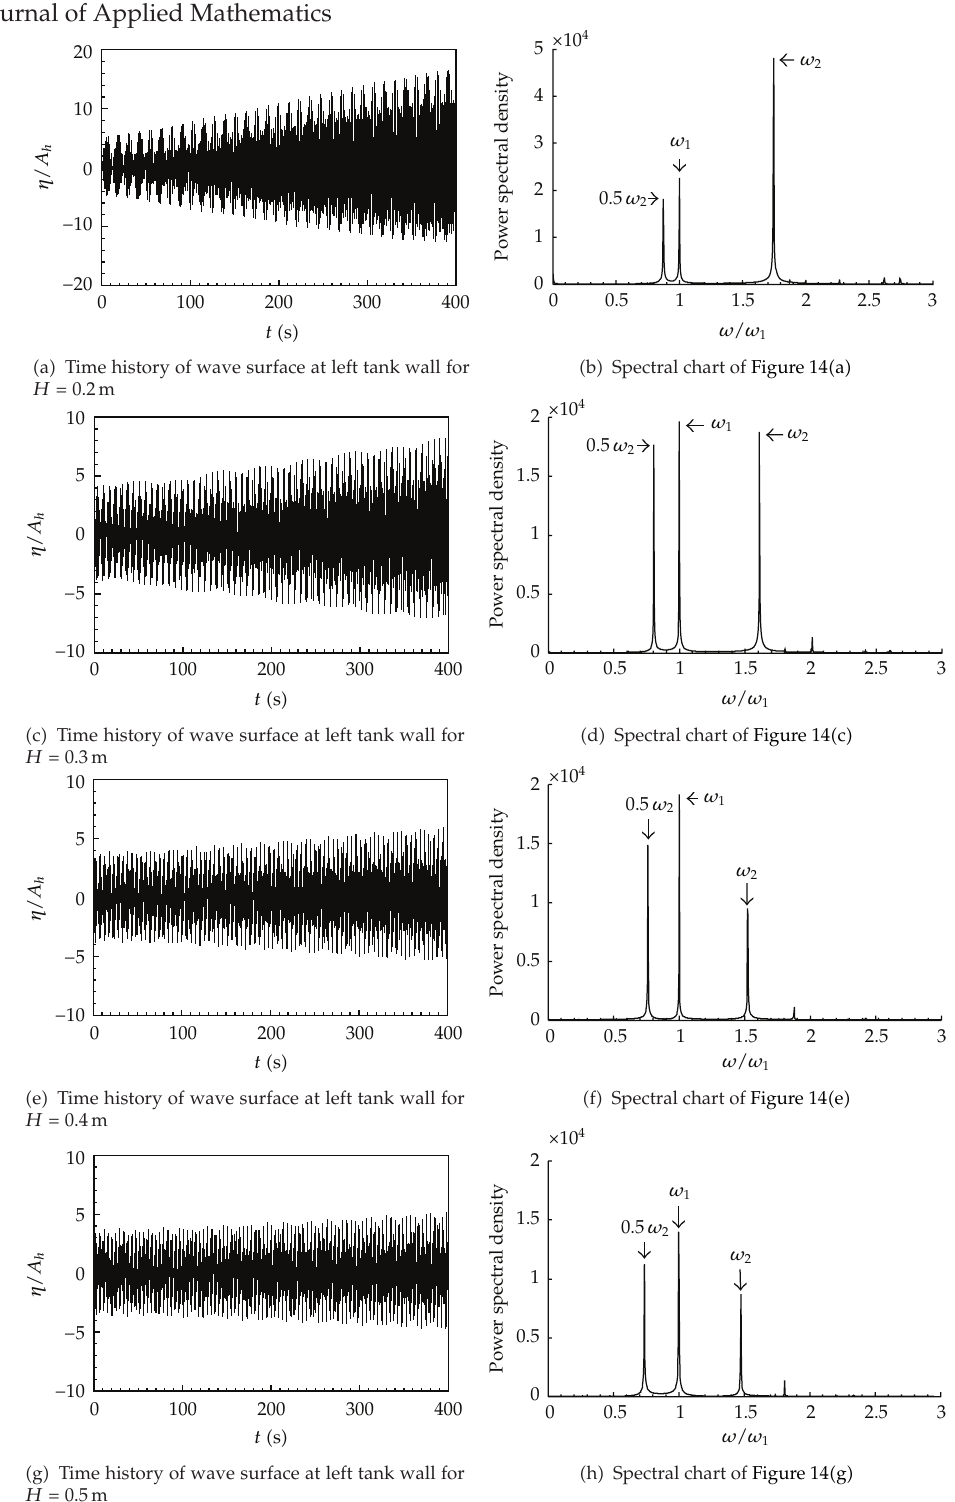
Figure 14: Time history of wave surface at left tank wall and the spectral charts for excitation frequency 0 . 5 ω 2